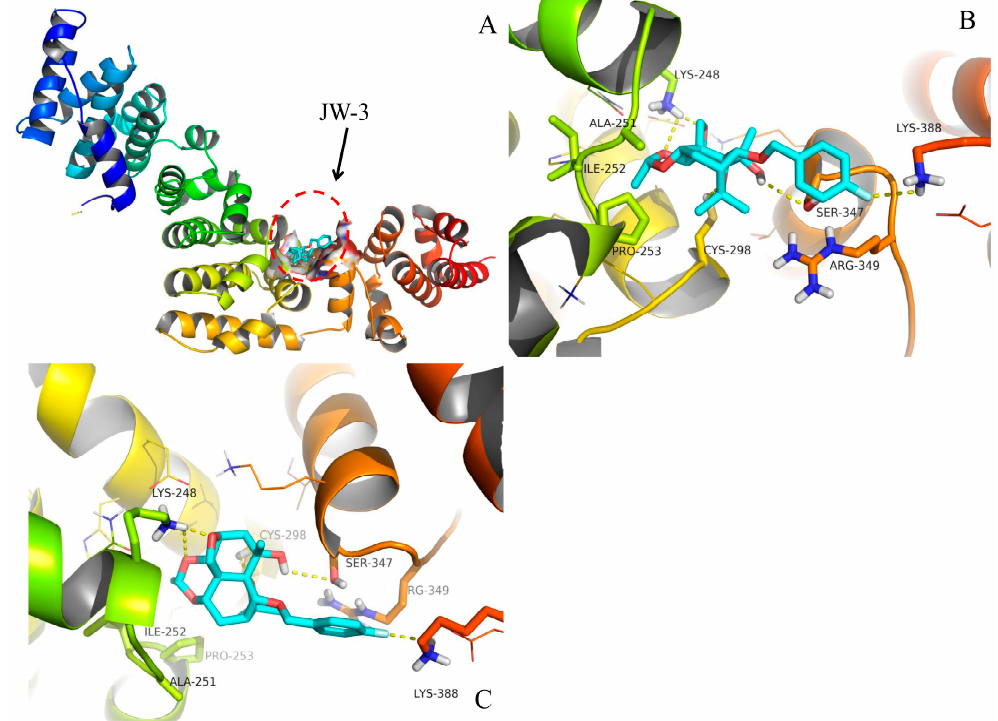
Figure 7. The binding model of JW-3 in the interdomain cleft of the M. separata V-ATPase subunit H ( A , global view; B , top view; C , front view). Compound JW-3 (C, cyan; O, red; F, silver) were shown in sticks. The key amino acids forming the pocket were represented in sticks and lines with different color. The hydrogen bonds were denoted by yellow dash lines.